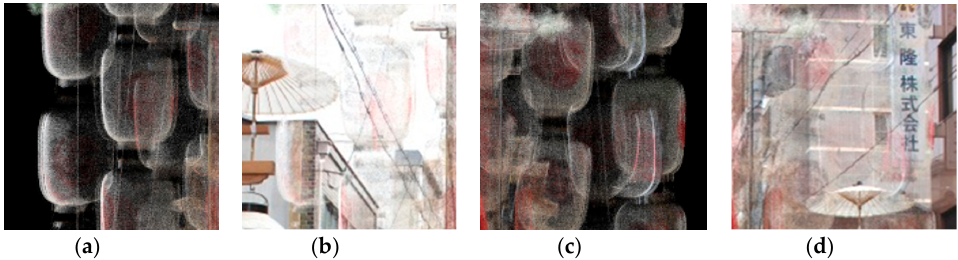
Figure 3. Local details of the visualization results in Figure 2: ( a ) partial enlargement of an upper left part of Figure 2a, ( b ) partial enlargement of an upper left part of Figure 2c, ( c ) partial enlargement of an upper right part of Figure 2a, and ( d ) partial enlargement of an upper right part of Figure